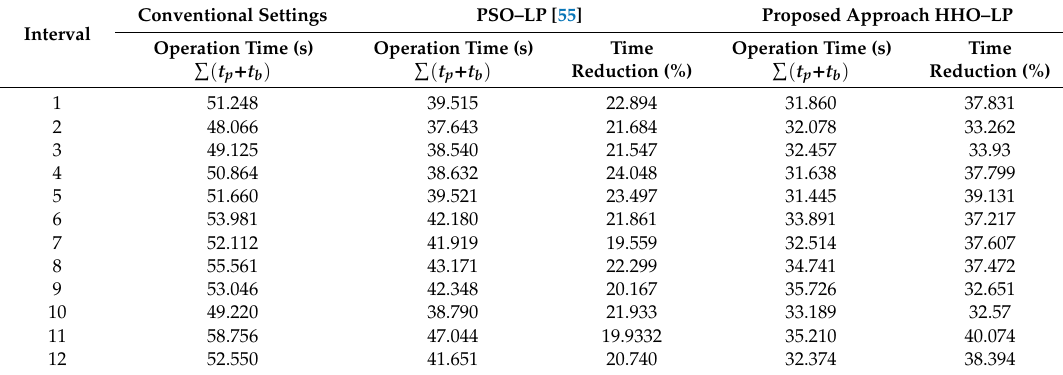
Figure 17. Operation time of primary–backup relays for all relay pairs on 15 July 2019 at ( a ) 10:00 a.m., ( b ) 10:05 a.m., ( c ) 10:10 a.m., ( d ) 10:15 a.m., ( e ) 10:20 a.m., ( f ) 10:25 a.m., ( g ) 10:30 a.m., ( h ) 10:35 am, ( i ) 10:40 a.m., ( j ) 10:454 a.m., ( k ) 10:50 a.m., and ( l ) 10:55 a.m. Table 10. Performance improvement in terms of the overall operation time of relays obtained using the proposed HHO–LP.